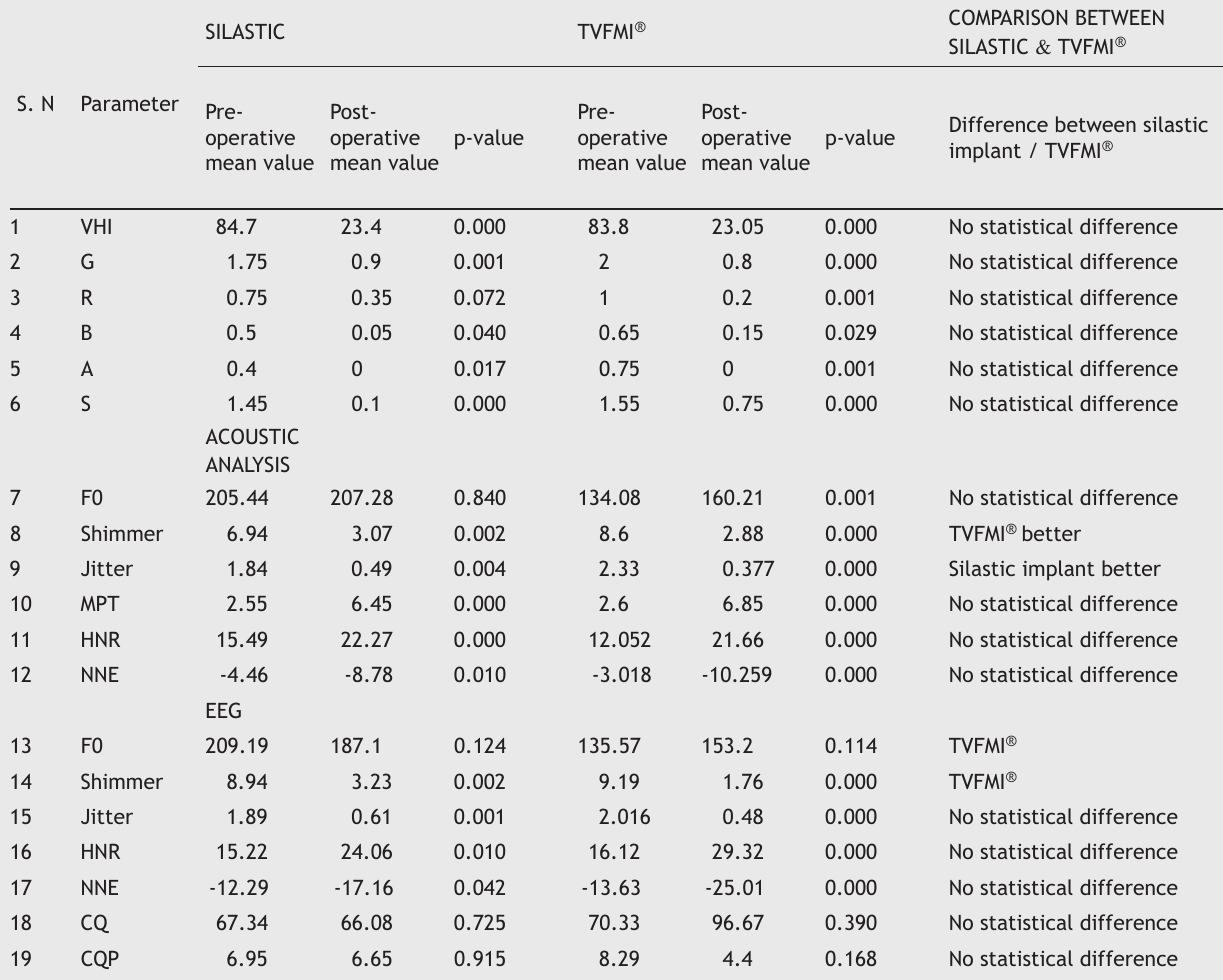
Table 1 Pre-operative ansd post-operative mean values of various parameters studied, and comparison of improvement between silastic implants and titanium vocal fold medializing implant (TVFMI ® ) (n = 40).